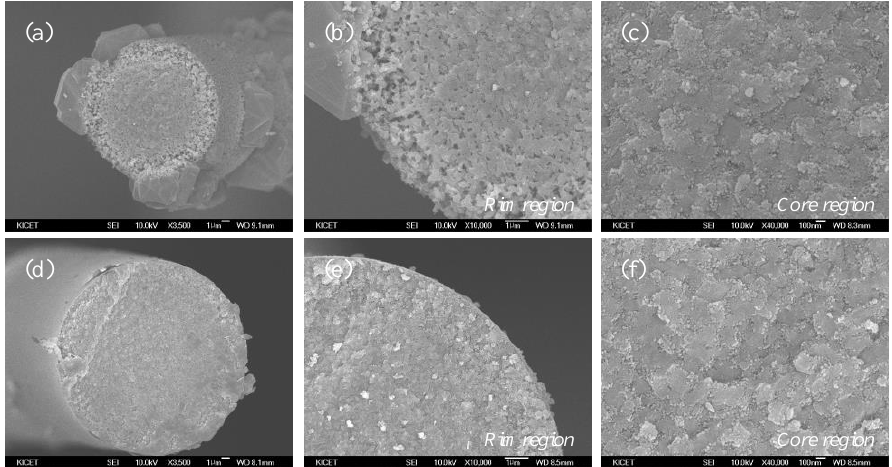
Figure 5. SEM images of polymer-derived SiC fibers fabricated at 1800 °C with ( a ‒ c ) uncontrolled and ( d ‒ f ) controlled pyrolysis process.